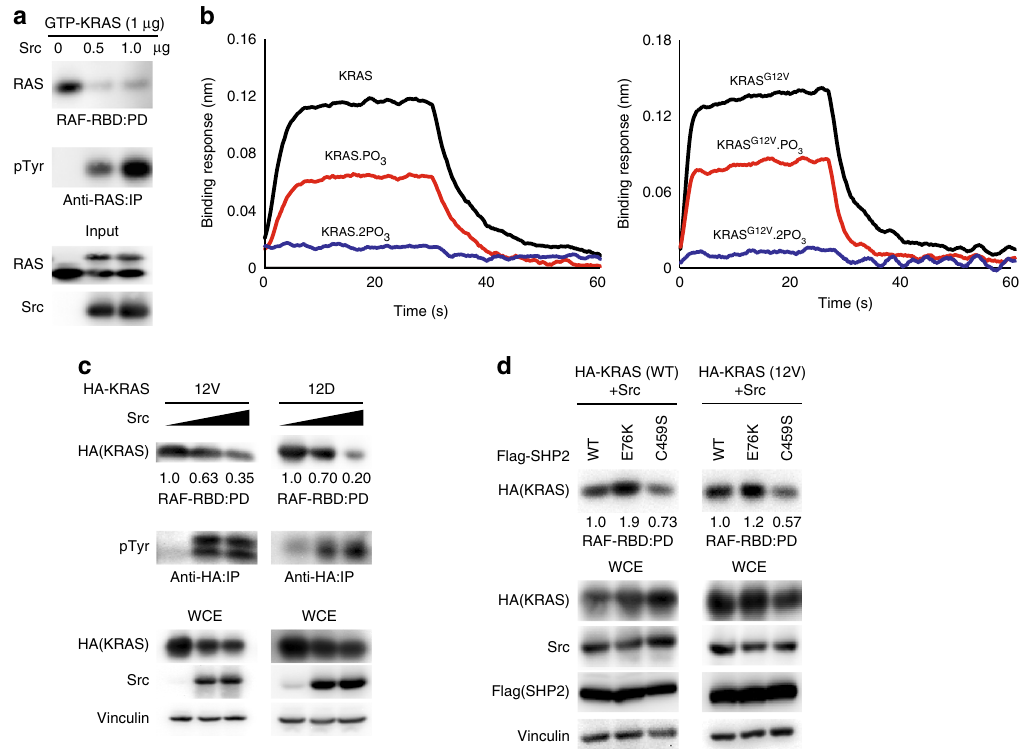
Fig. 6 Tyrosyl phosphorylation of KRAS attenuates binding to RAF. a Puri fi ed recombinant human GTP-bound KRAS protein was subjected to in vitro kinase assay using puri fi ed recombinant Src kinase and pulled down using Raf-1:RBD-conjugated beads or immunoprecipitated and immunoblotted with the indicated antibodies. b The binding of un-, mono-, and di-phosphorylated KRAS, each at a concentration of 250 nM, to immobilized GST-BRAF-RBD was measured using biolayer interferometry (Octet). The full binding curves at a range of KRAS concentrations is shown in Supplementary Fig. 8. Left panel: wild-type KRAS. Right panel: KRAS G12V mutant. c , d HEK293 cells were transfected with the indicated plasmids. Cells were lysed, pulled down using Raf-1: RBD-conjugated beads, or were immunoprecipitated and immunoblotted with the indicated antibodies. Numerical values indicate the ratio of quanti fi ed signals over the control (lane 1 of each panel; set at 1.0) determined by densitometry using the ImageJ software. The immunoblot data are representative of at least three independent experiments. PD